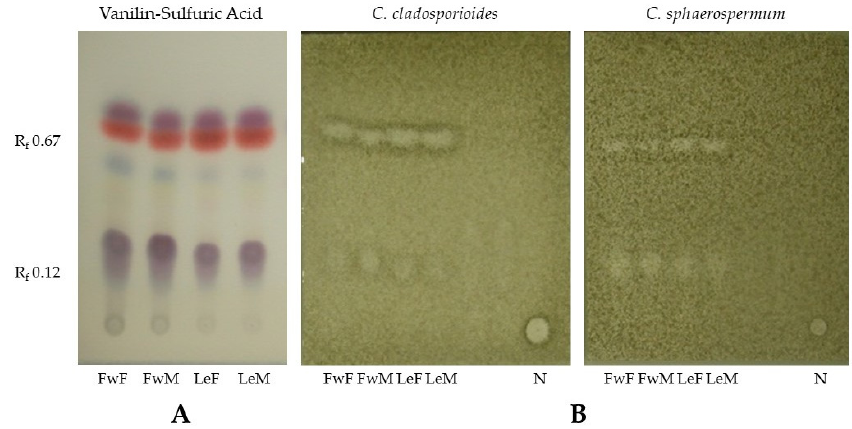
Figure 3. ( A ) Detection of terpenes of H. brasiliense essential oils by Vanilin-Sulfuric Acid (VS) spray reagent followed by heating to 110 ◦ C; ( B ) Antifungal activity of Hedyosmum brasiliense essential oils, developed with n -hexane/acetone (90:10, v / v ), against Cladosporium cladosporioides and C. sphaerospermum . R f 0.67 = strong activity; R f 0.12 = weak activity; FwF = female flowers; FwM = male flowers; LeF = female leaves; LeM = male leaves; N = nystatin. Table 2. Chemical composition of the active antifungal fractions of H. brasiliense female flowers and leaves essential oils isolated by bioautography-guided TLC. Compound